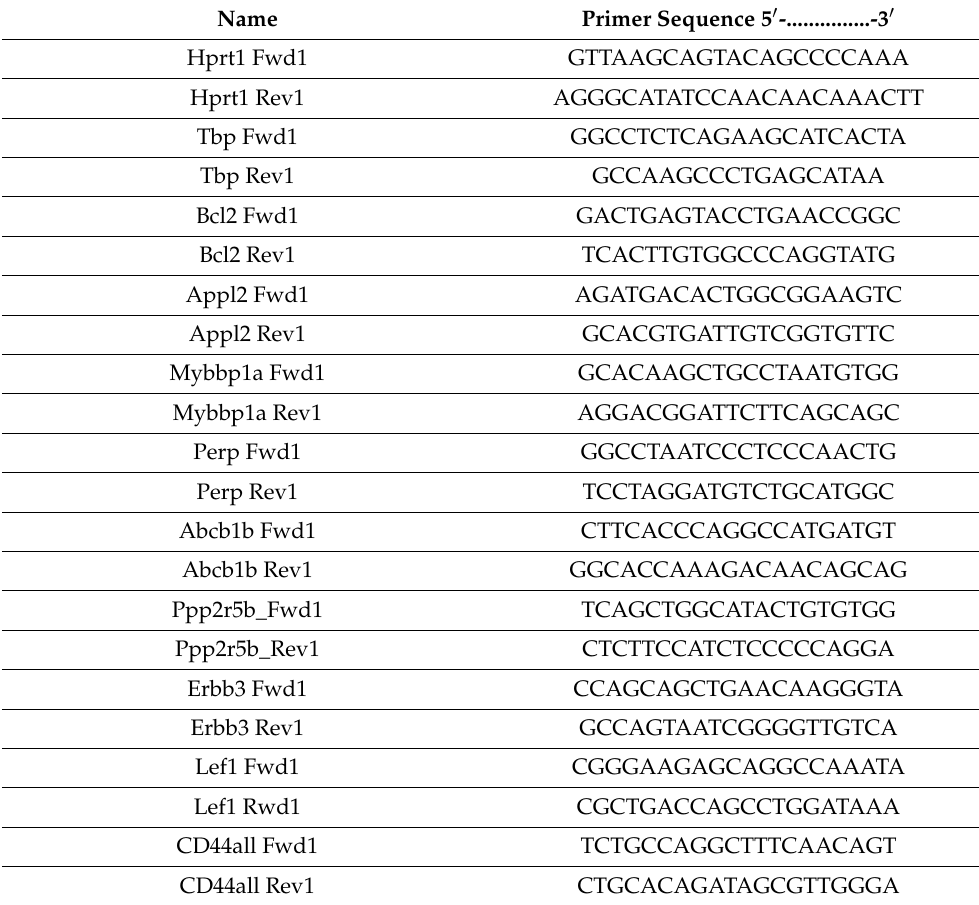
Table 2. Oligonucleotides used for real time